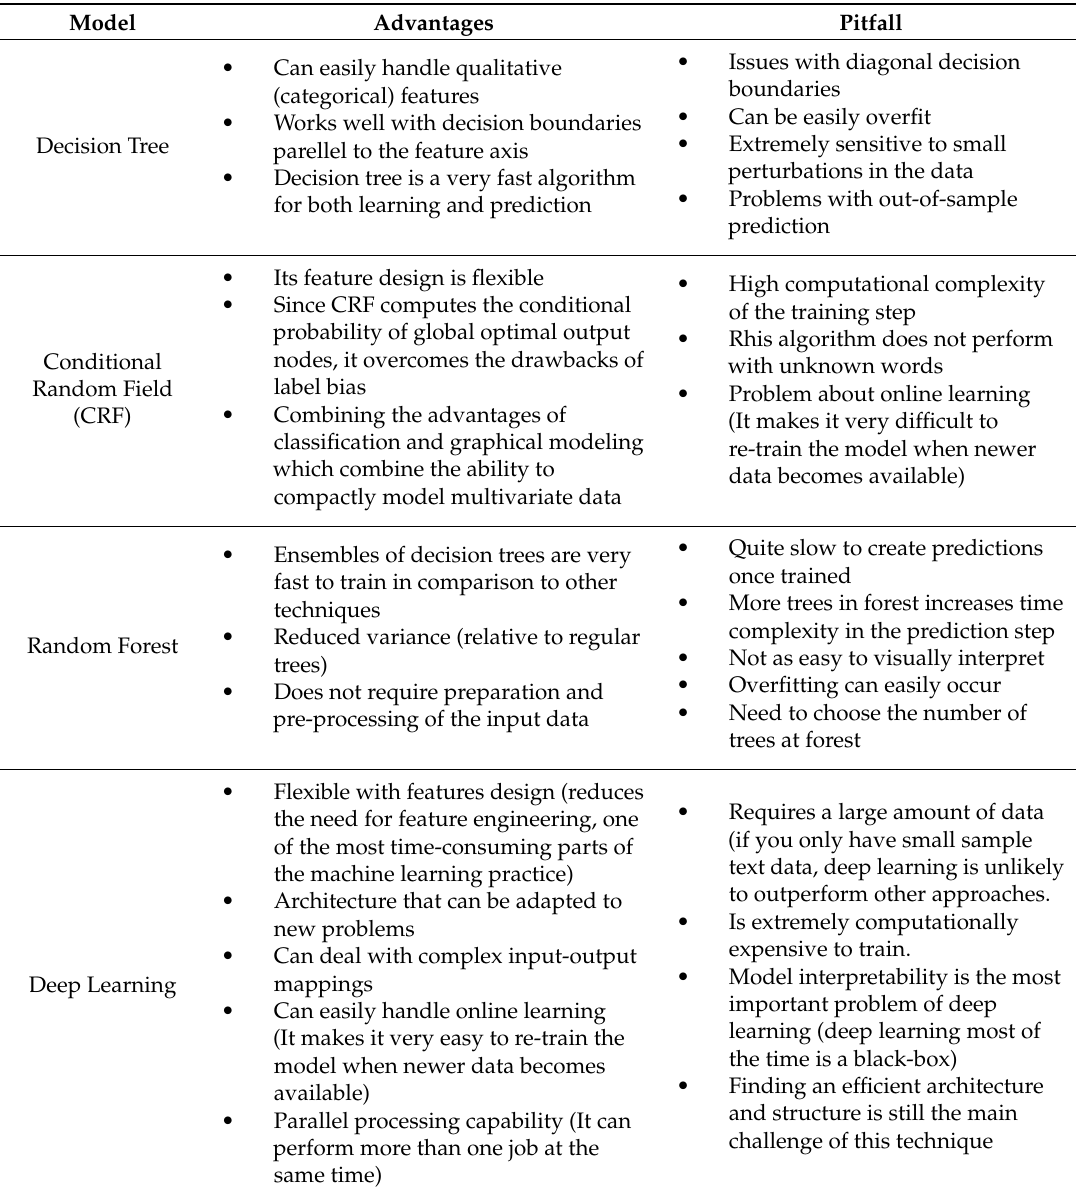
Table 3. Text classification comparison (decision tree, conditional random field(CRF), random forest, and deep